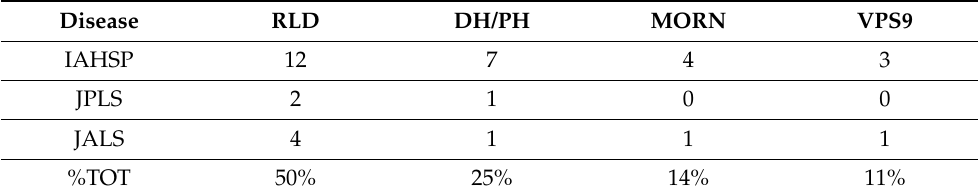
Table 3. Frequency of mutations divided into different predicted domains.